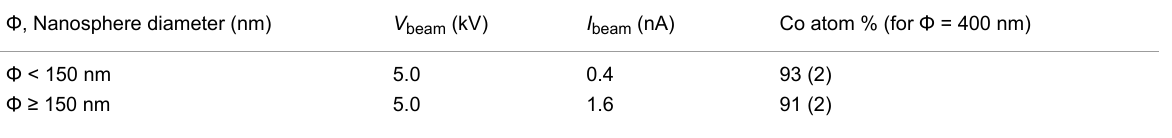
Table 1: Growth parameters used for the cobalt nanospheres in the present study. In the last column, the cobalt content (atomic percent) of a cobalt nanosphere of 400 nm in diameter grown under the reported conditions is given with the measurement precision in parentheses. Φ , Nanosphere diameter